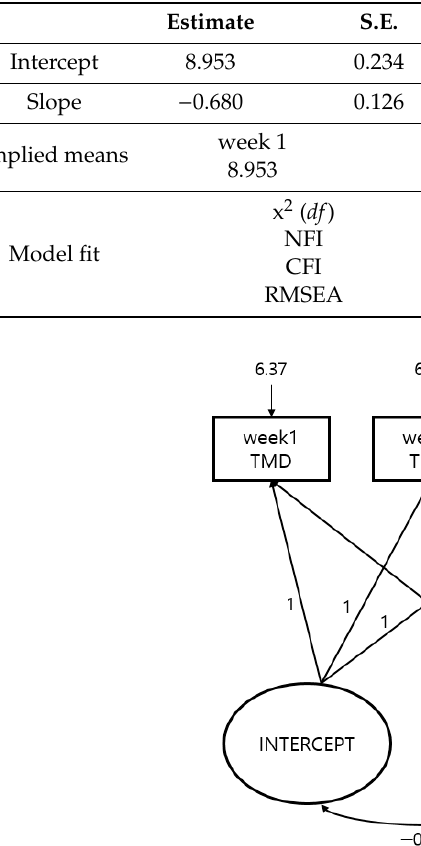
Table 6. Changes in TMD over time per fitness levels.